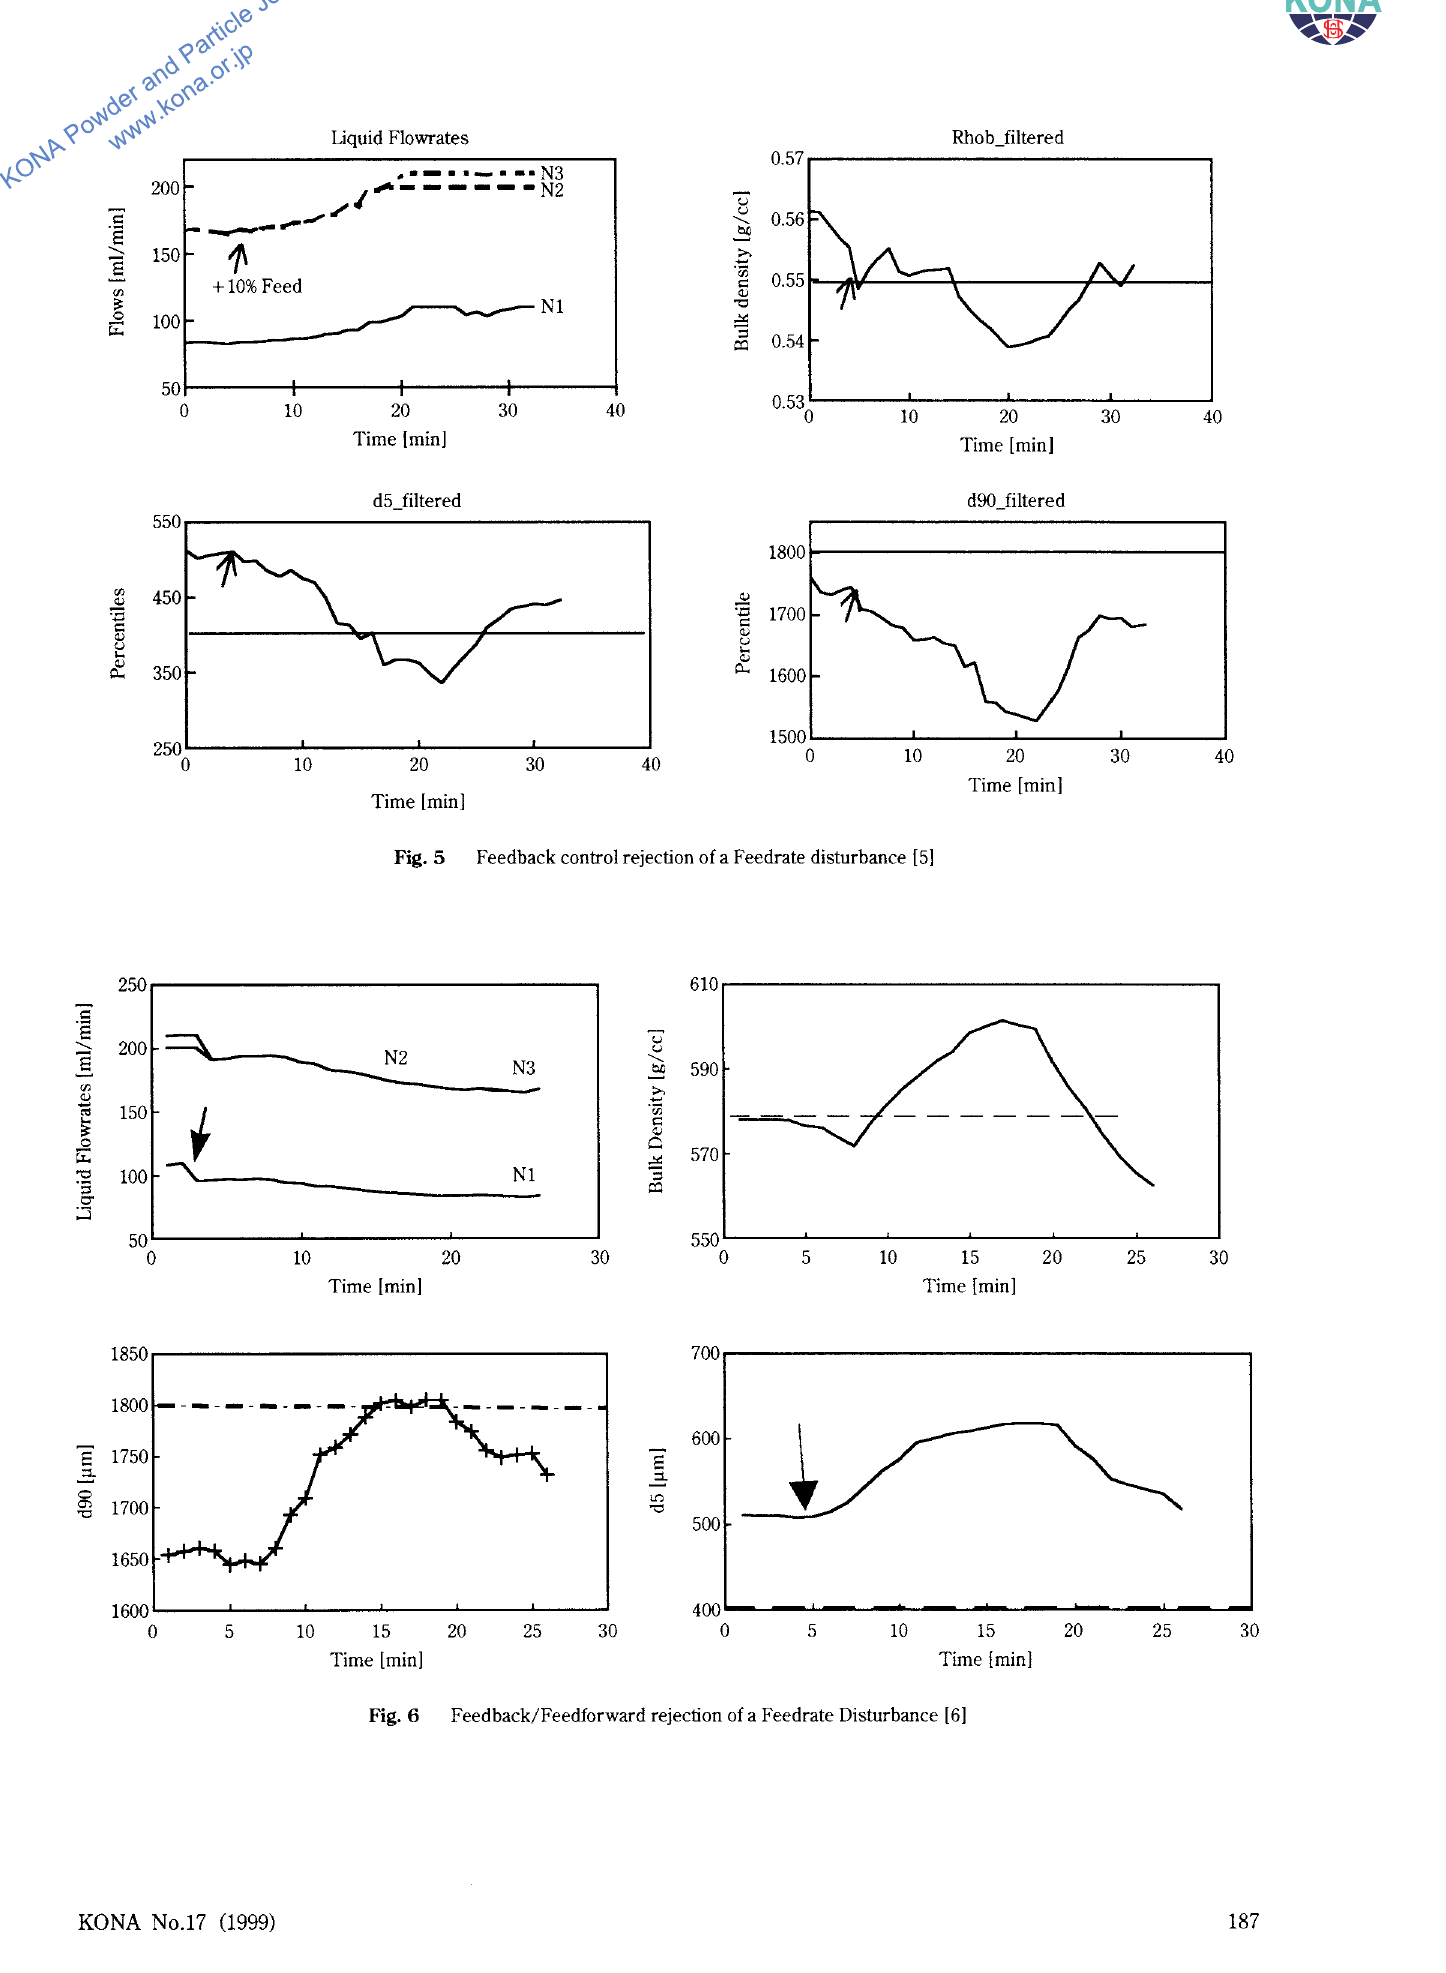
Fig.6 Feedback/Feedforward rejection of a Feedrate Disturbance